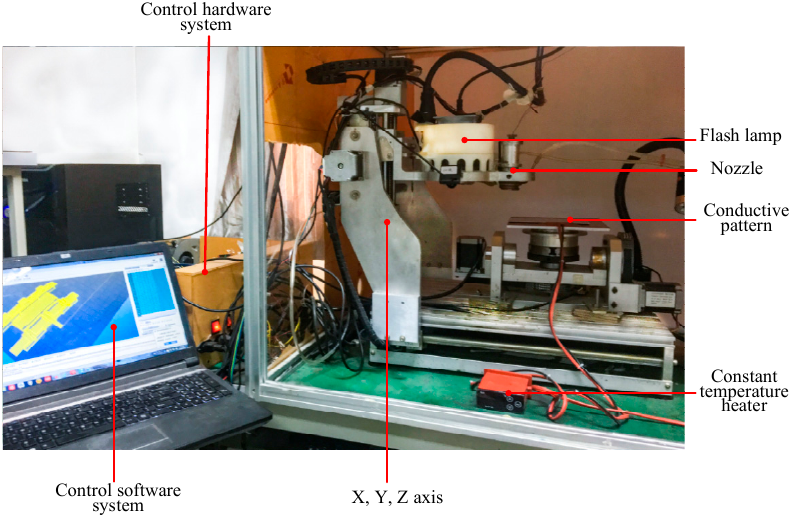
Figure 1. Sintering mechanism of silver nano-ink conductive pattern under flash irradiation.